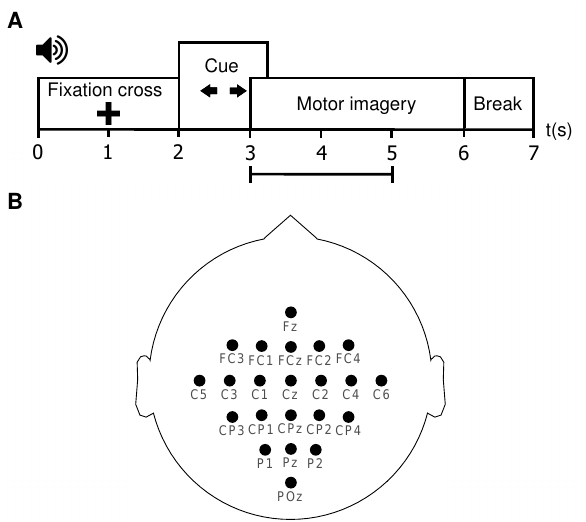
Figure 2. ( A ) Schematic representation of the MI protocol. ( B ) EEG channel montage used for the acquisition of the MI